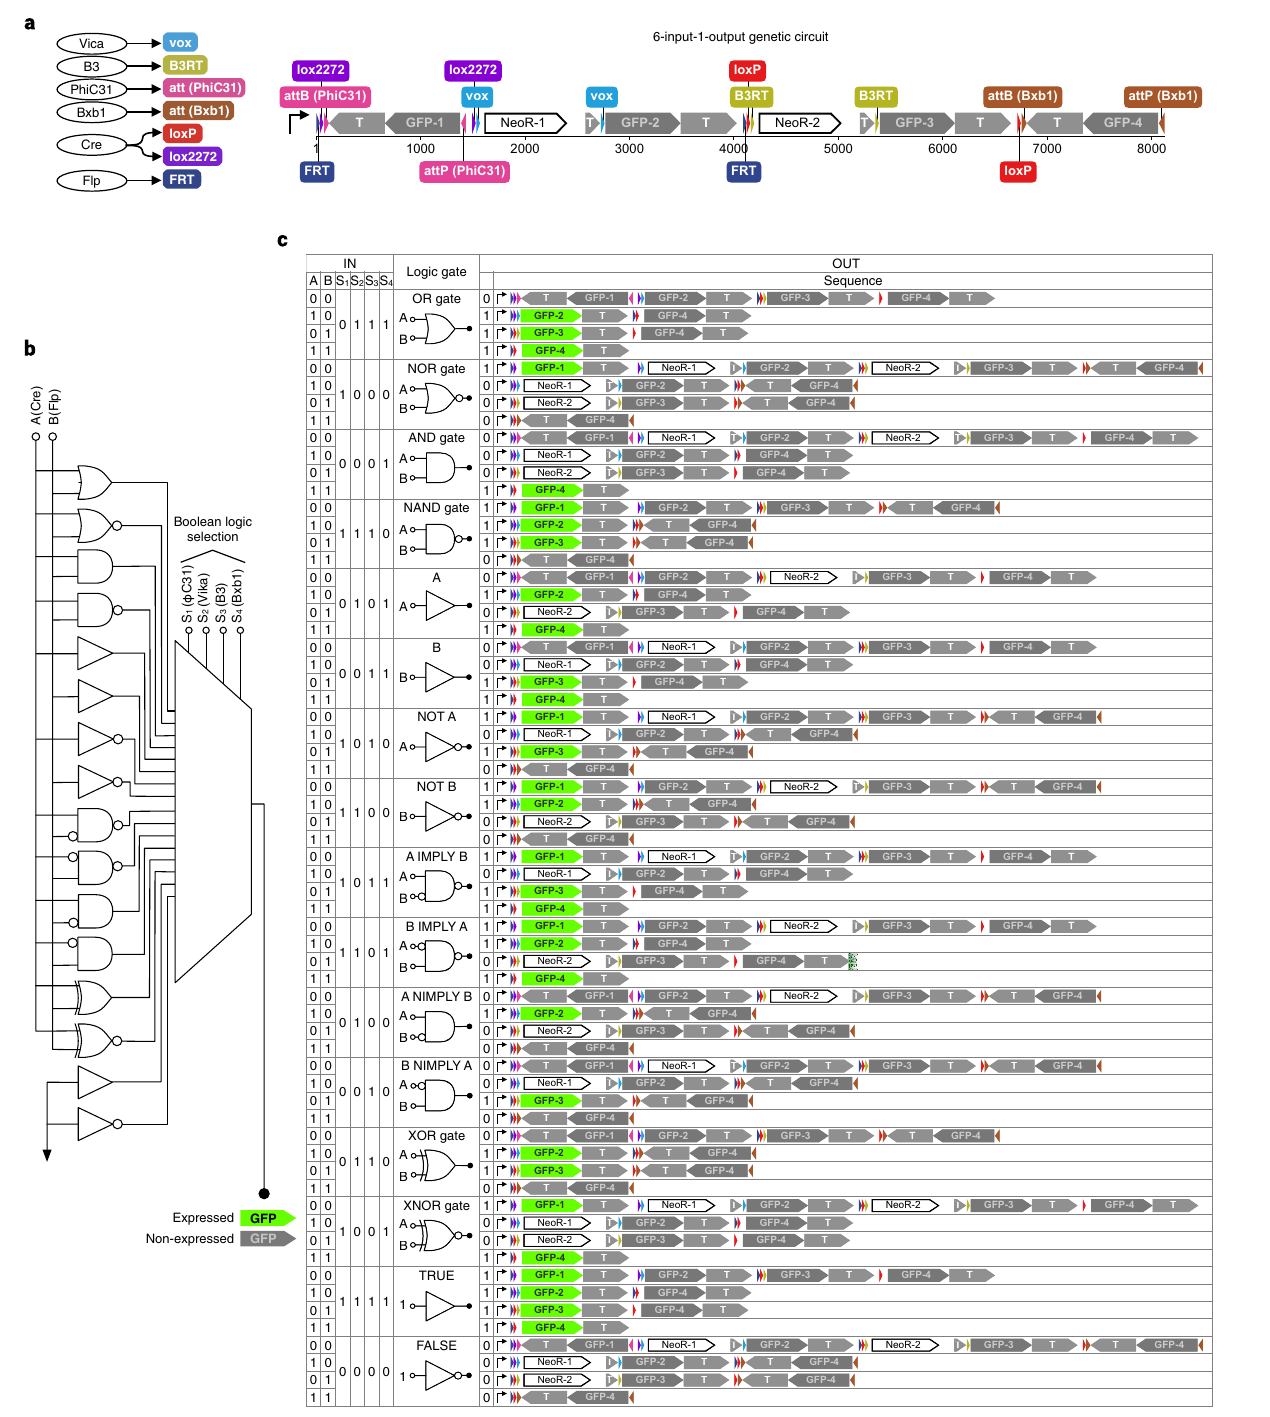
Fig. 5 Simulation of a Boolean logic LUT. a The six-input, one-output Boolean logic LUT of the BLADE system. Left, site-speci fi c DNA recombinases (round nodes) and their corresponding target DNA sites (round rectangles). Right, the genetic Boolean logic LUT circuit. b The wiring diagram of the genetic circuit. c Annotated DNA sequence outcomes of each signal input pattern simulated by QUEEN. GFP expresses if one of the GFP-encoding genes is placed in the same direction as the upstream promoter without being prevented by a transcription